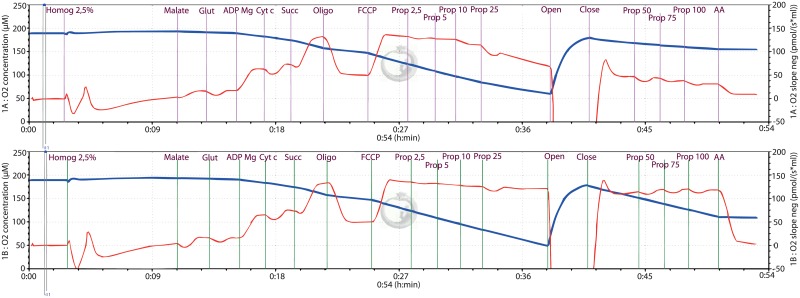
Example of SUIT high resolution respirometry protocol.The two measurements performed in the presence of propofol (μg/ml) or vehicle (ethanol) as control.